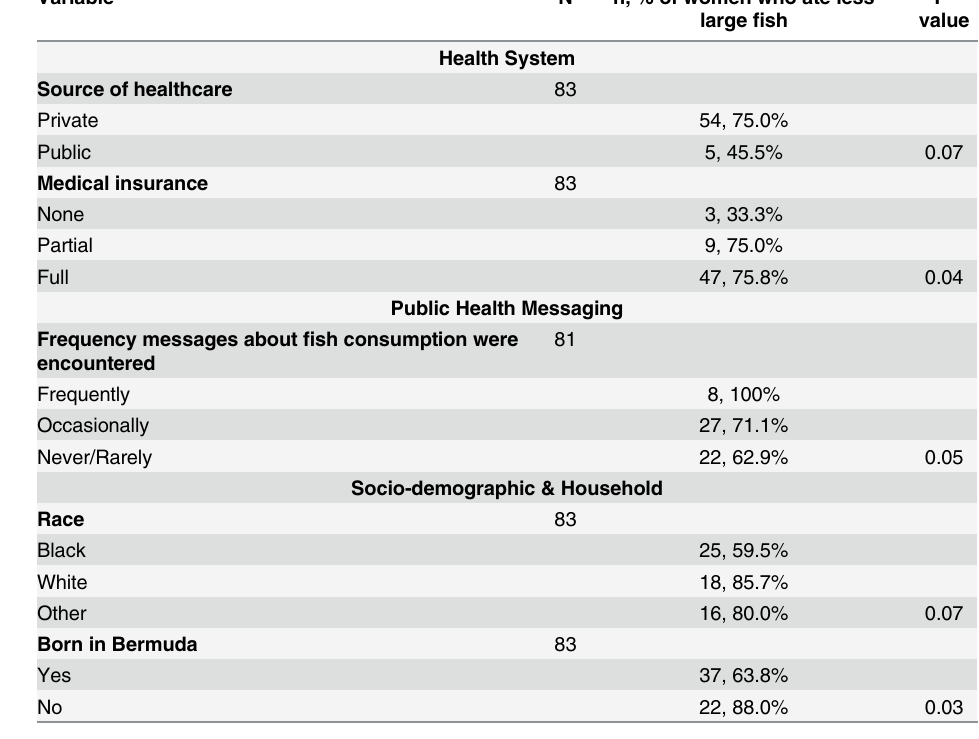
P- large fi sh value Health System